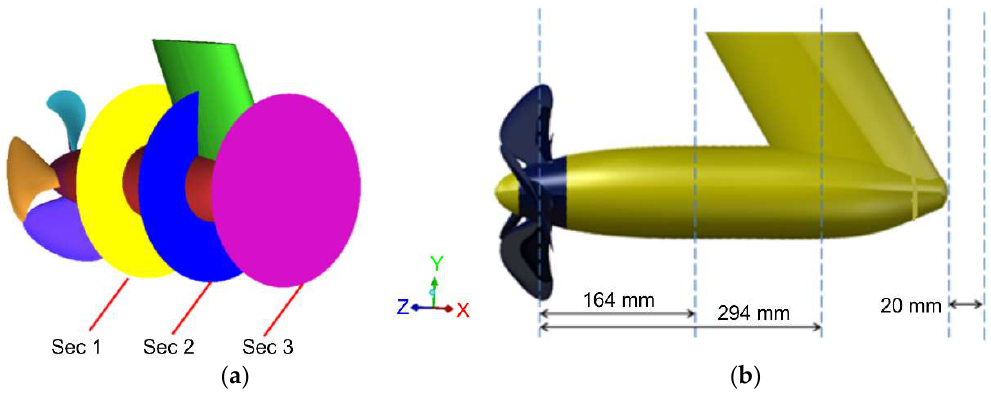
Figure 3. Flow-field cross-sections for the L-type podded propulsor ( a ) Drawings of three measured